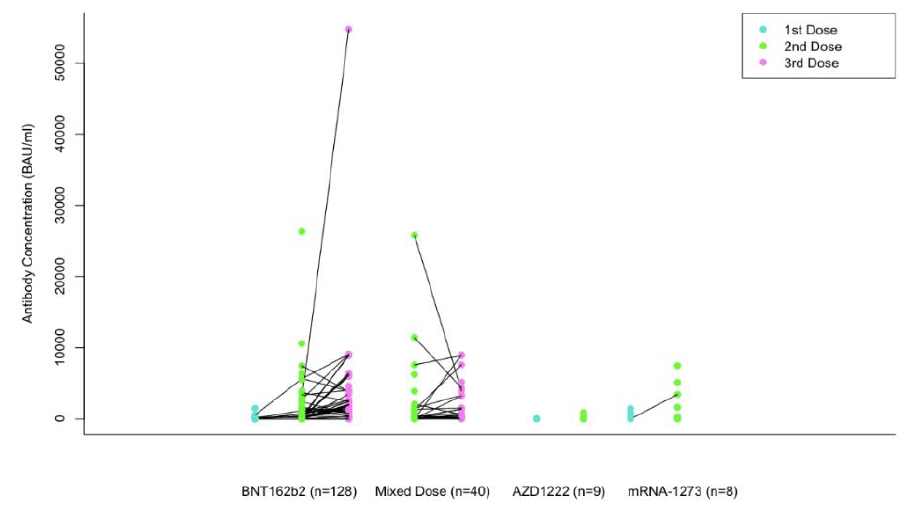
Figure 2. Changes of antibody concentration following first, second and third dose in several types of vaccines in cancer patients.